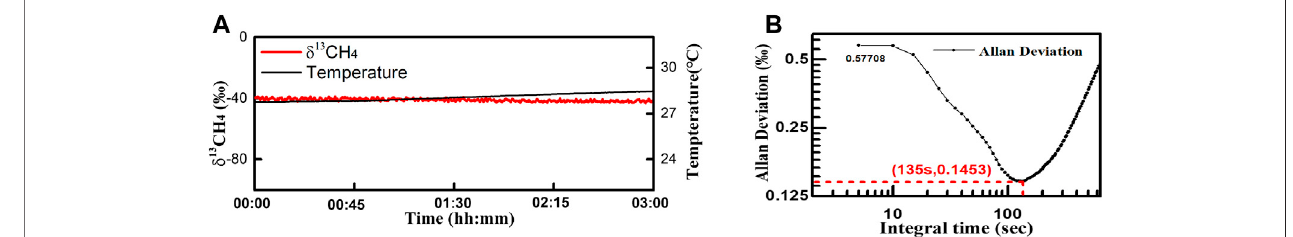
FIGURE 9 | (A) Long term test of δ 13 CH 4 and (B) Allan